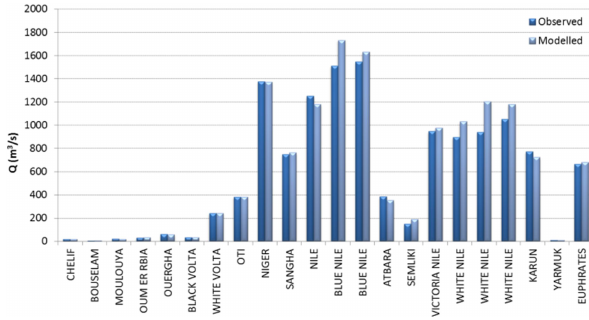
Fig. 5. Long-term average annual observed and simulated